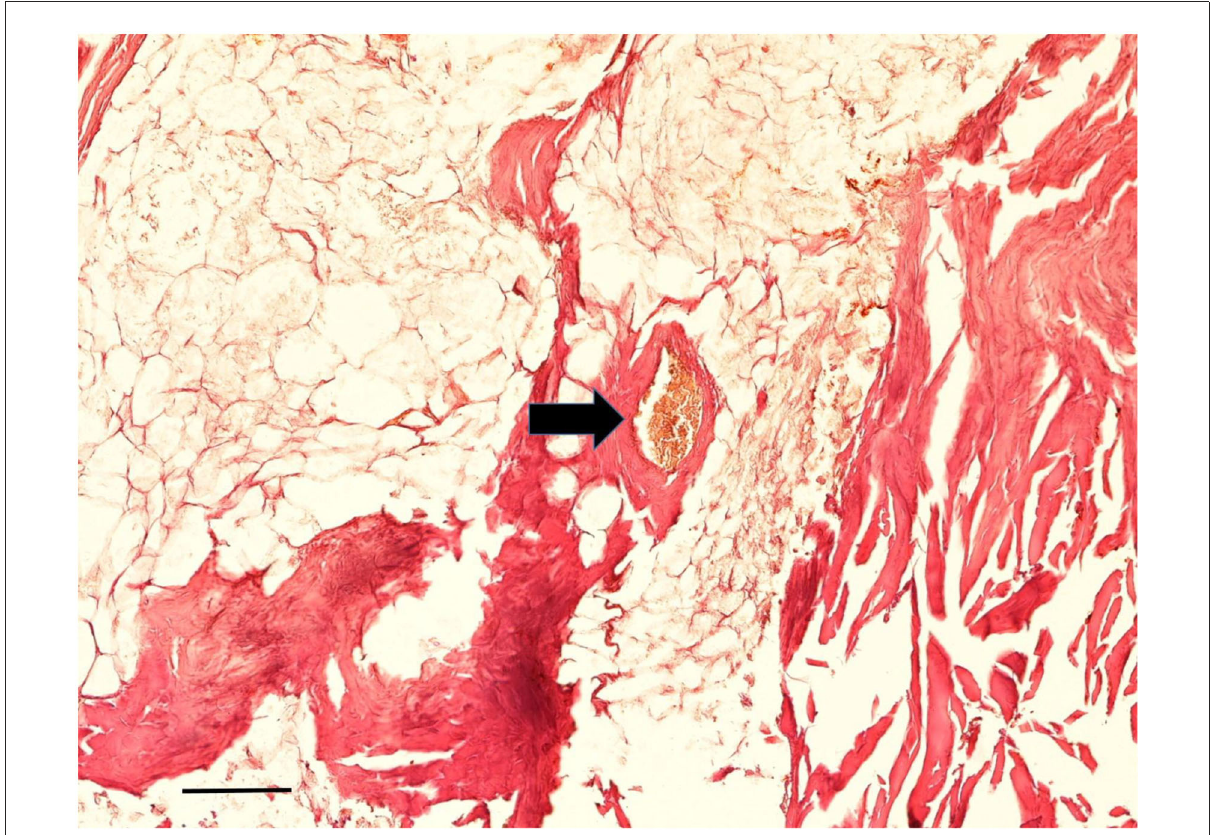
FIGURE12 Histological examination of subcutaneous tissue. Subcutaneous fat tissue with little effects of adipocere transformation is seen together with typical small blood vessels (arrow) (Staining: H&E; bar: 100 µ